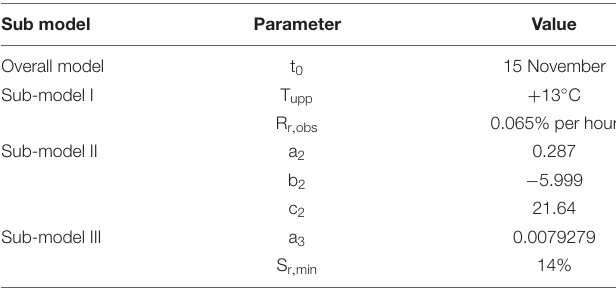
TABLE 2 | Parameter values of the process-based leaf-out phenology model developed in this study for first-year seedlings of subtropical pecan.